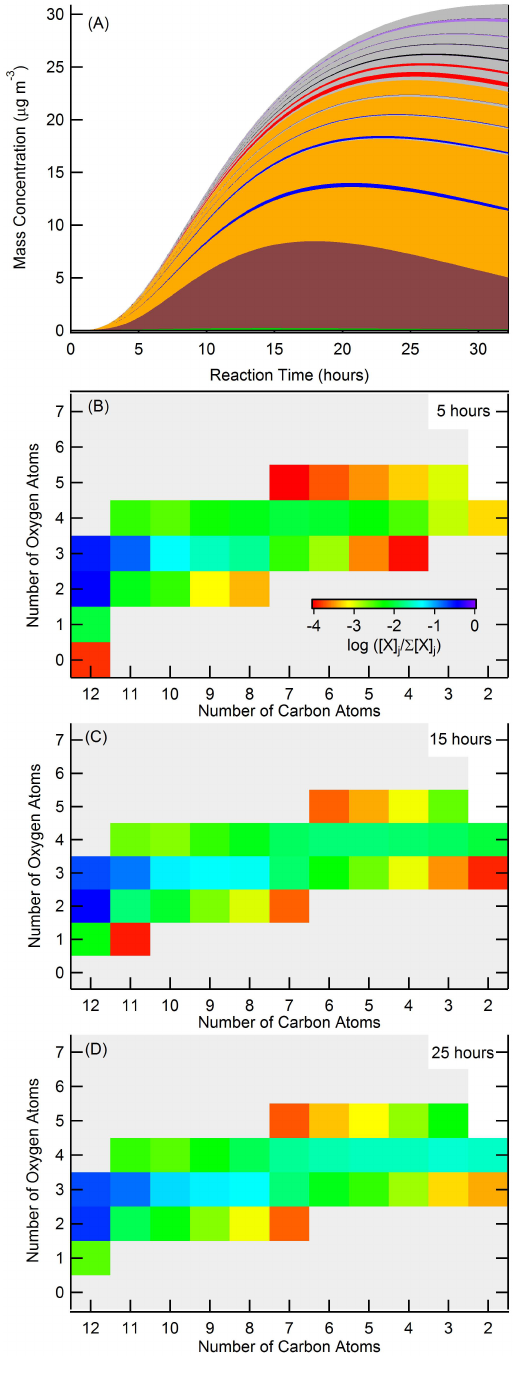
Fig. 7. (A) Simulated mass concentrations of each SOM species, with each species stacked on the previous. The colors correspond to those in Fig. 6 and indicate species of a particular “cluster”. (B) , (C) and (D) show snapshots at 5, 15 and 25 hours of reaction, respec- tively, of the normalized mass concentration of all SOM species on an oxygen/carbon grid, with concentration indicated by the color of each cell in the grid (see legend). For each snapshot, the mass con- centration of each species is normalized by the total SOA mass con- centration as in Fig. 4; species with a normalized abundance < 10 − 4 are shown as gray and species with O:C > 2 are shown as